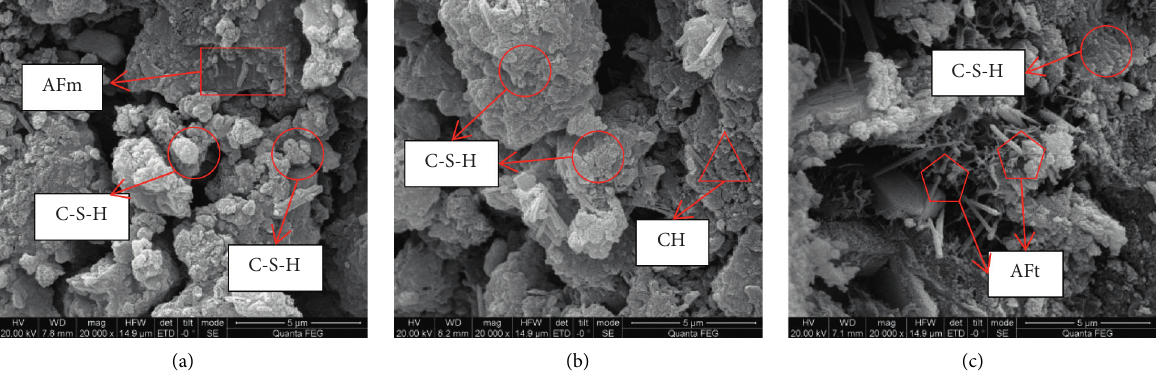
Figure 7: The micromorphology of ordinary cement materials at different curing ages. (a) Curing for three days, (b) curing for seven days, and (c) curing for sixty